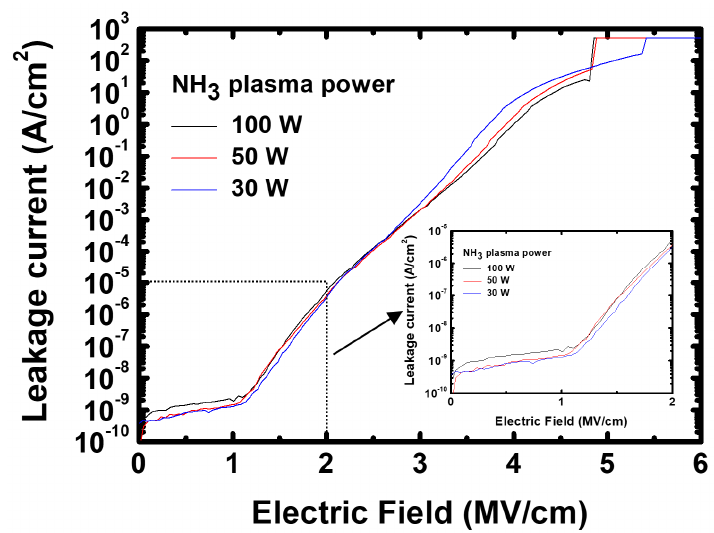
Figure 6. J–E characteristics of the MIS capacitors.